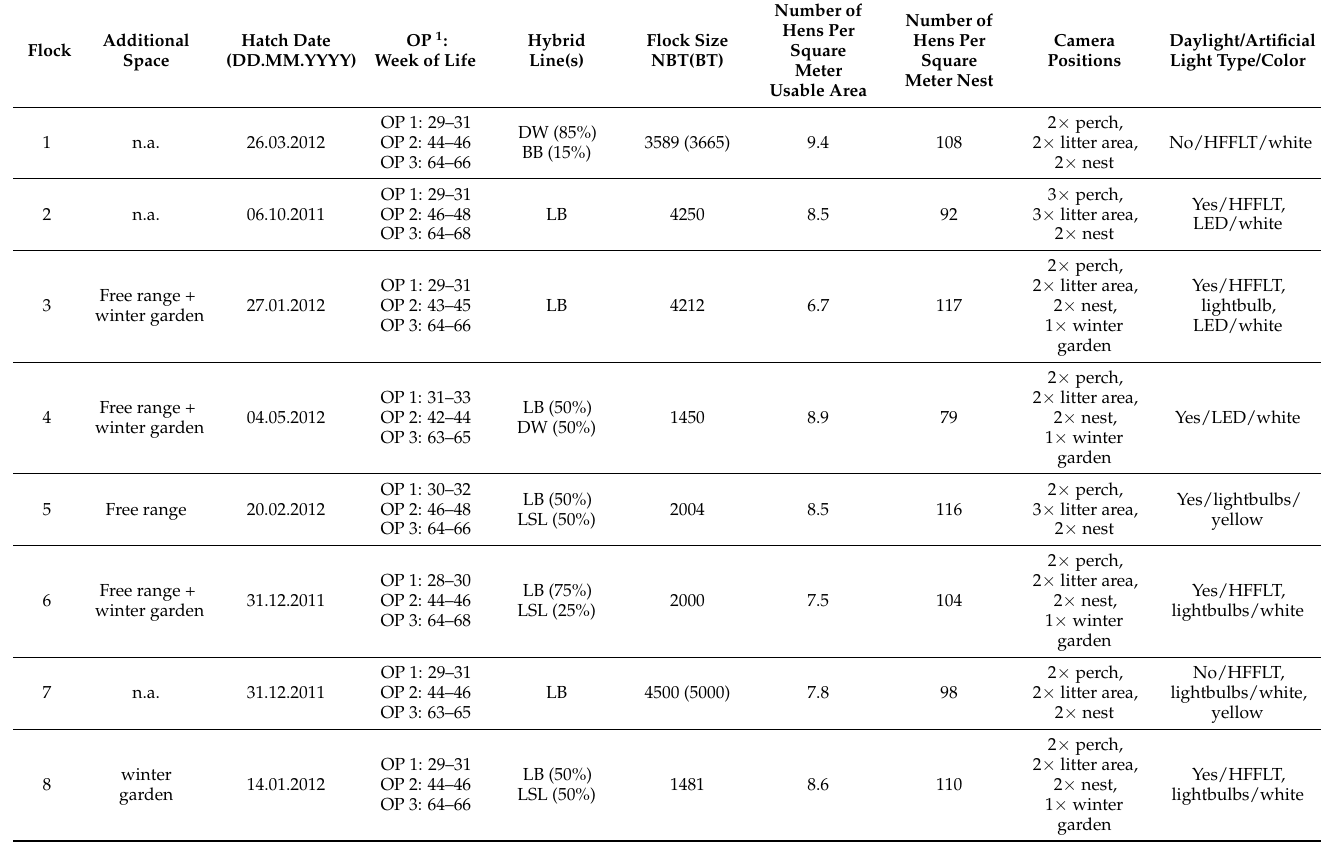
Table 1. Overview of the flocks, their housing conditions and the distribution of the video cameras. All flocks were housed in